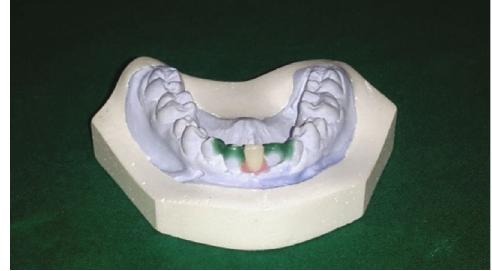
Figure 8: Intraoral photograph showing immediately after extraction of 81.